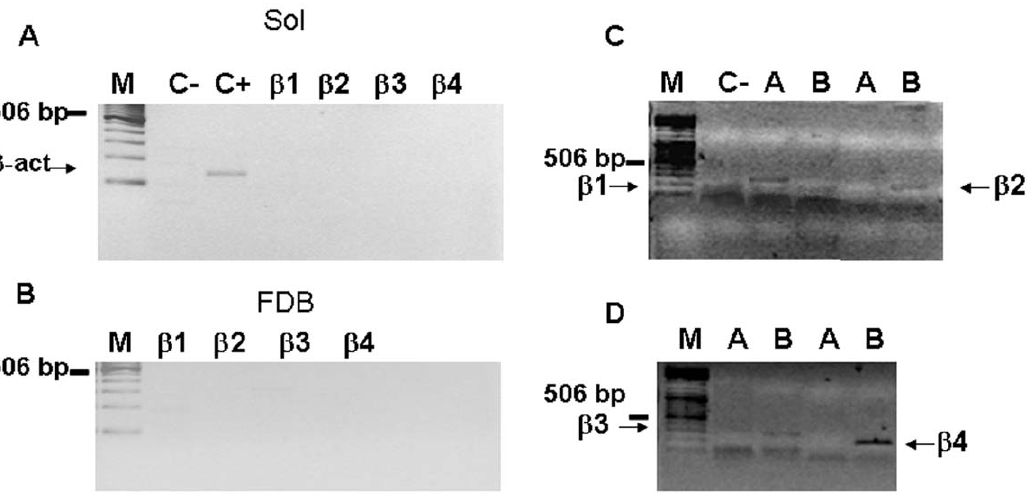
Figure 3. PCR of Rat BK accessory beta -subunits in different tissues. ( A–B) Representative ethidium bromide-stained agarose gel of amplicons generated from a PCR screen of rat Sol (A) and FDB (B) cDNA beta 1-4 subunits. M, marker; C- negative control; C + positive control (rat actin). (C–D) Representative ethidium bromide-stained agarose gel of beta 1-4 subunits amplified by PCR on positive samples: brain B for beta 2-4 and aorta A for beta 1.